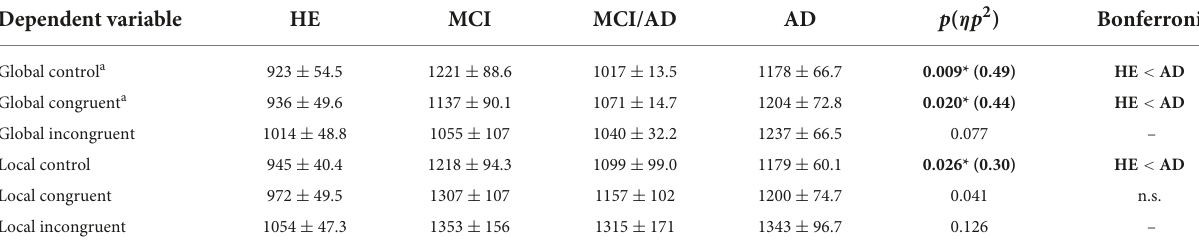
TABLE 5 Results of one-way ANOVAs using the factor Group and pairwise comparisons of the RpTs obtained in the Navon task at the 2nd moment of the assessment.